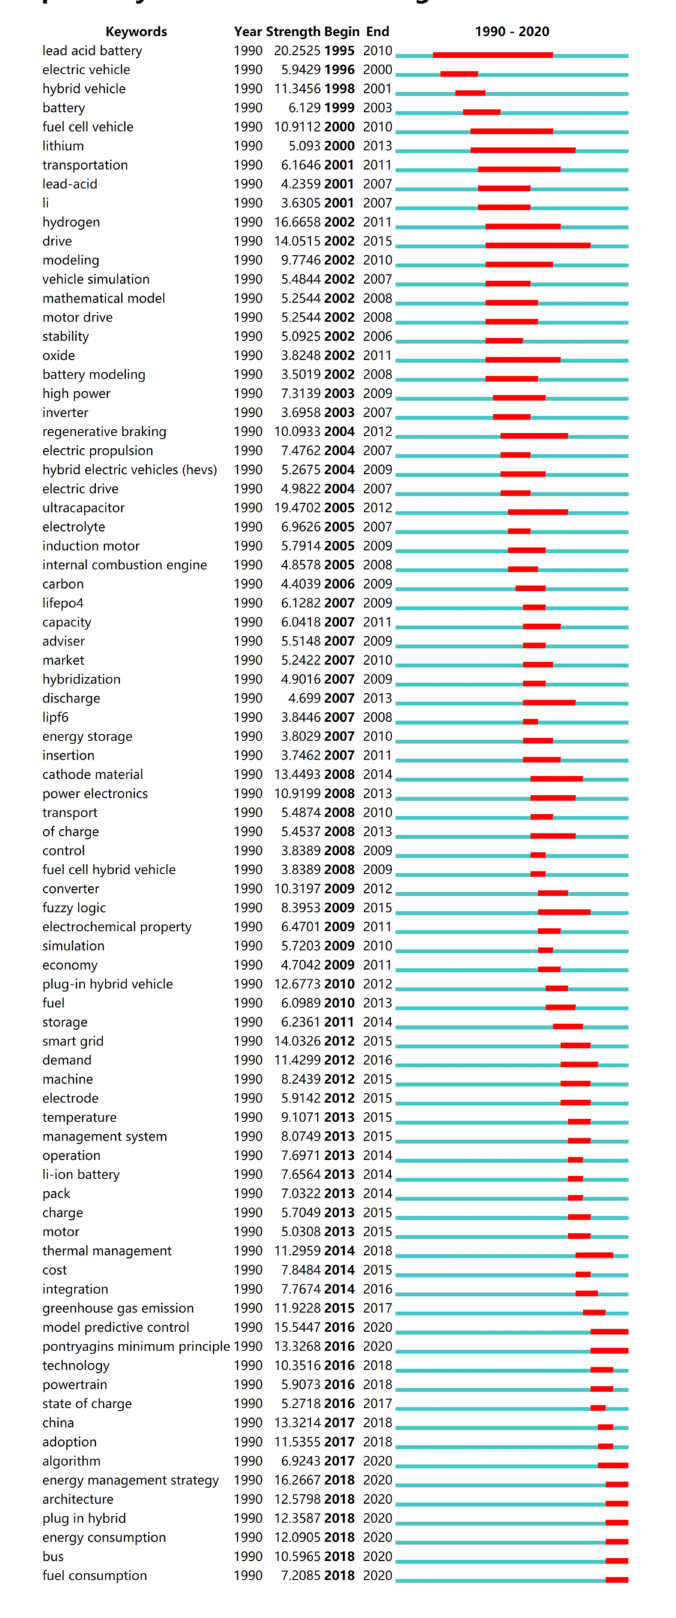
Figure 10. Keyword burst of HV